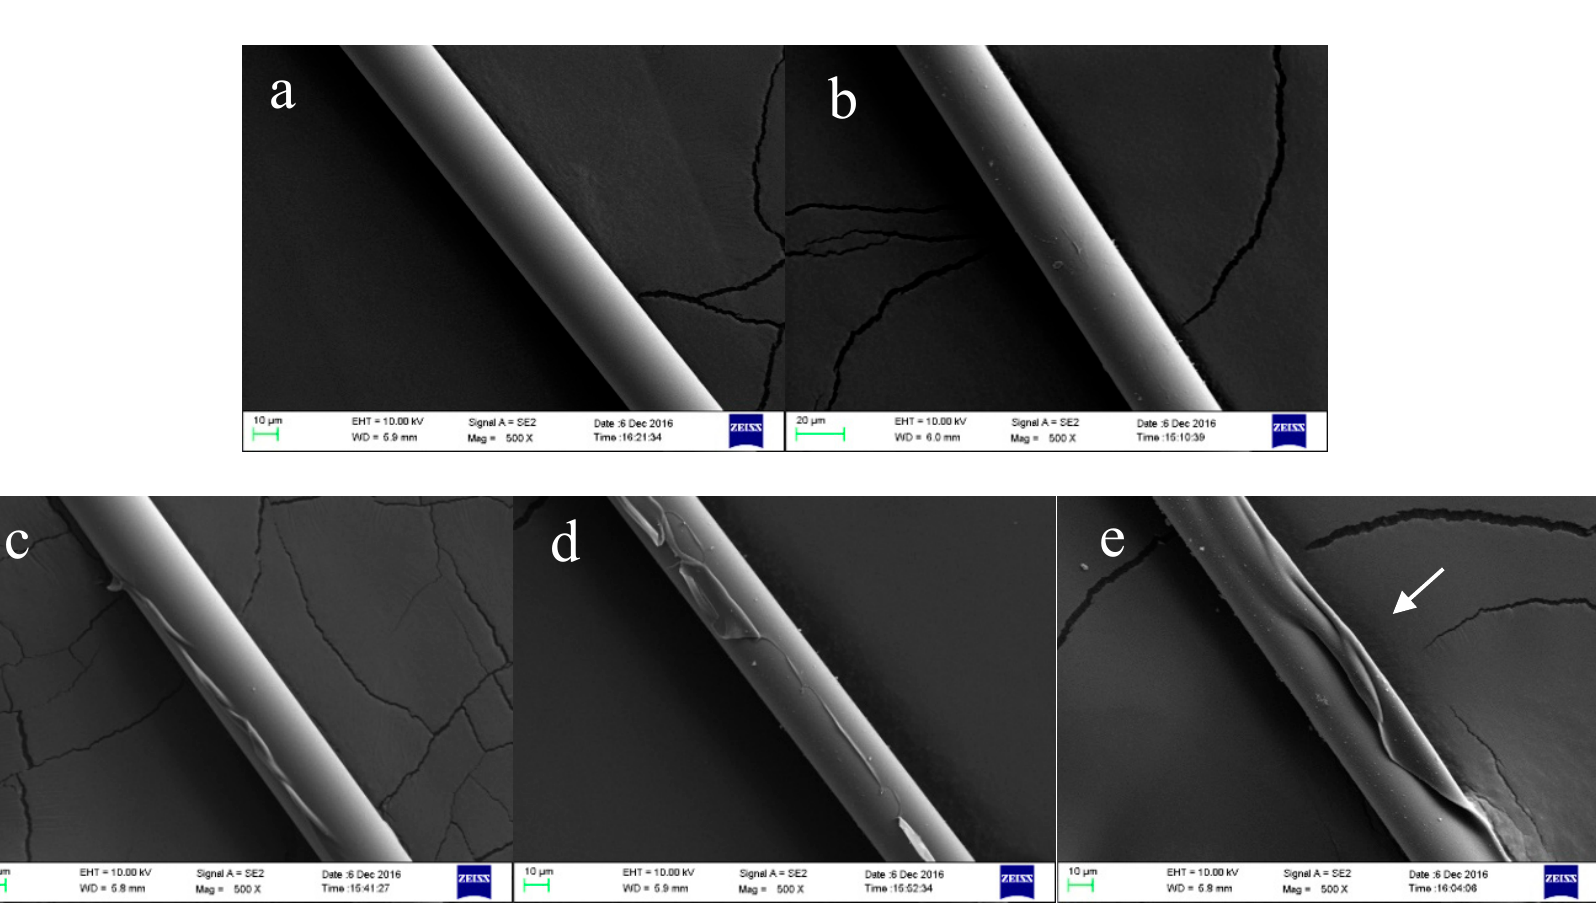
Figure 3. SEM images of coated/uncoated phosphate glass fibres (PGFs). Subfigures ( a – e ) show PCP- 0, -3R, -3, -6, and -9, respectively; the scale-length of a = 10 μ m, the magnification (Mag) of a = 500×, and ( a – e ) share the same factors. ( f ) shows blistering of the PCP-3 fibre surface heated by the electron beam; the scale-length of f = 2 μ m and the Mag of f = 2000×. ( g ) shows two combined PCP-3 filaments; the scale-length of g = 10 μ m and the Mag of g = 1200×. The cracked base shows the conductive tape. 3.4. TGA Figure 4 represents the change in weight percentage of CS powders and glass fibres as a function of temperature. A derivative of the weight percentage curve (Wt%/°C versus °C) is also presented for a further analysis of decomposition temperature. Figure 4a shows the TGA results of the CS powders, where two apparent peaks were observed on the derived Wt curve of CS at 86 and 310 °C, respectively. The weight loss in the temperature between 230 and 400 °C was observed to be 43%, which was caused by the decomposition of CS [27]. Figure 4b exhibits TGA traces of the coated and uncoated fibres. A peak at ~300 °C was observed on the derived Wt curves of PCP-3, -6, and -9. One more peak was found at ~160 °C for PCP-6 and -9. In addition, an obvious weight loss was found for PCP-3, -6, and -9 below 100 °C. Table 3 shows the corresponding peaks of derived Wt curves for CS powders and glass fibres. The weight loss behaviour was observed to be composed of three stages.